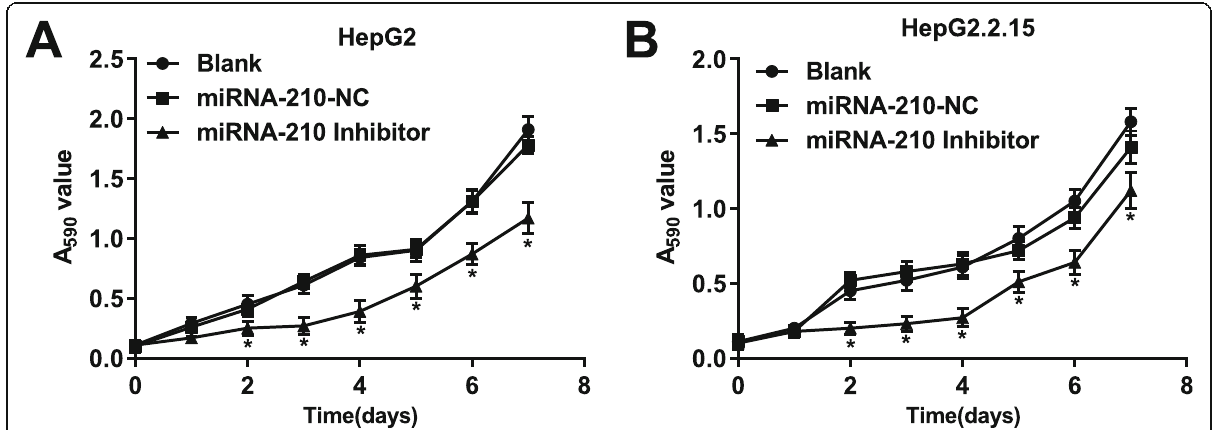
Fig. 3 Silencing of miRNA-210 inhibited the viability of HepG2 a and HepG2.2.15 b cells. * P < 0.05 compared with the Blank group. The